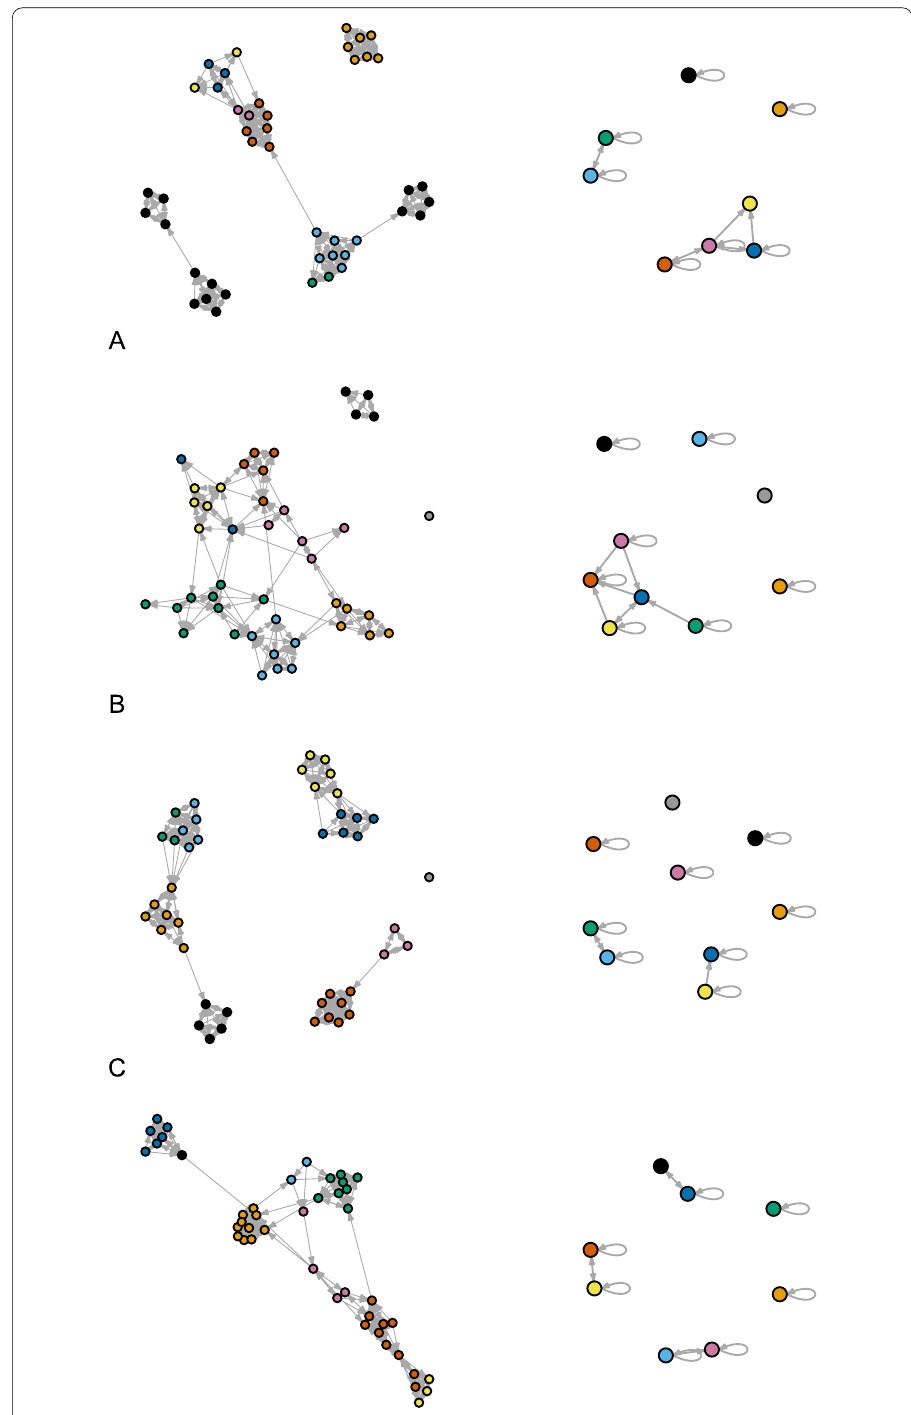
Fig. 4 Fall 2015 sociograms (left column) and reduced networks (right column) for exams 1–4, partitioned using the CONCOR